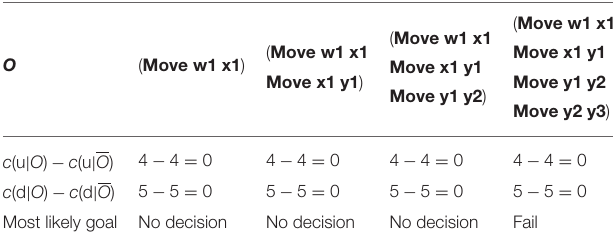
TABLE 1 | Observer modeled as a plan recognition agent for the grid navigation example in Figure 1